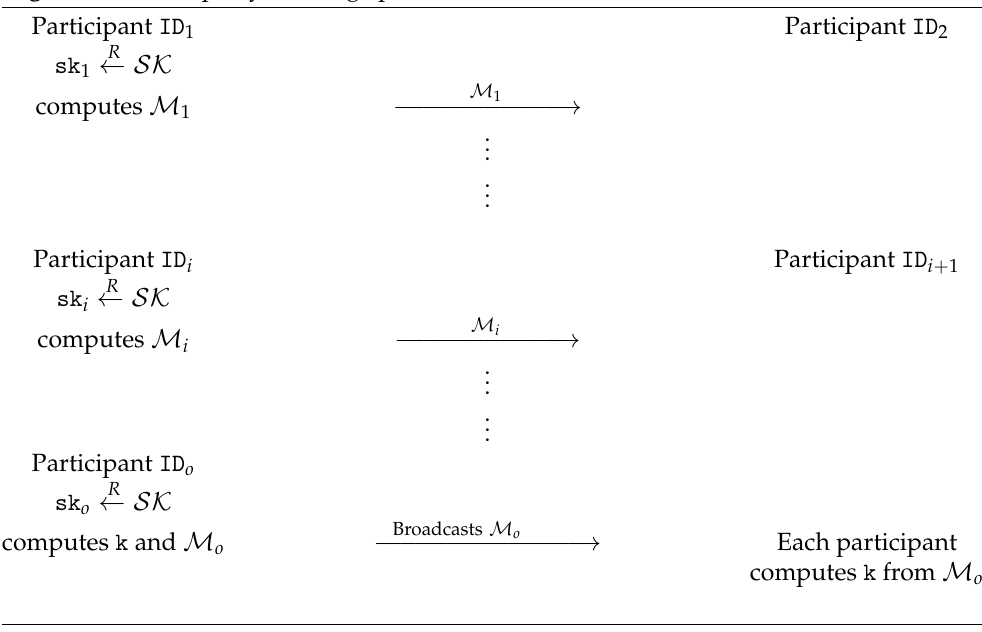
Algorithm 3 Group key exchange